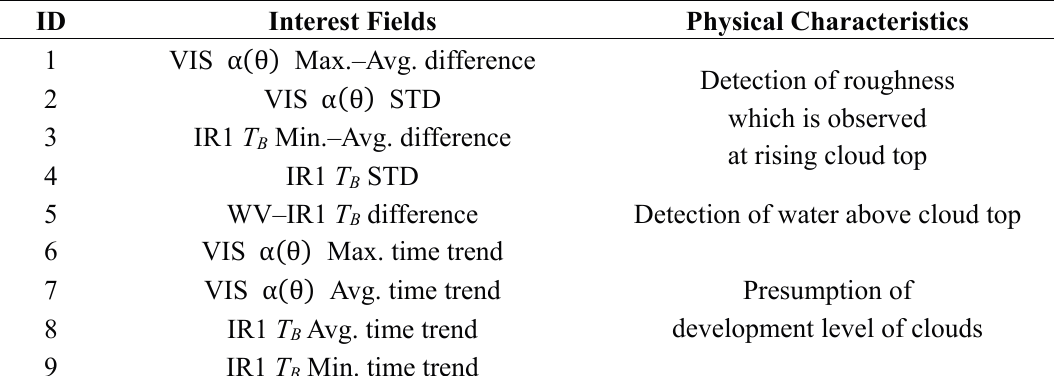
Interest Fields Physical